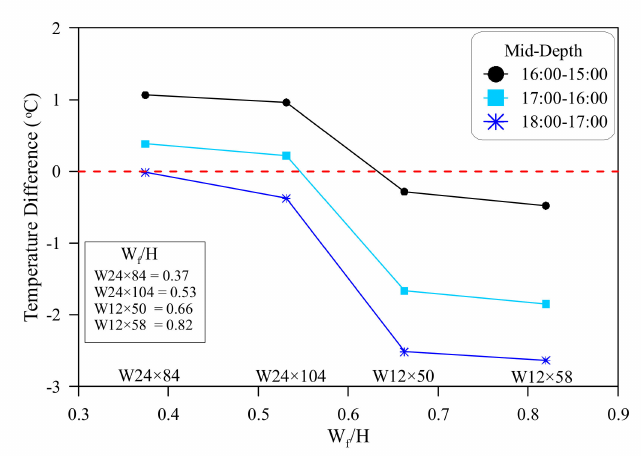
Figure 12. Relationship between mid-depth temperature and W f / H at afternoon